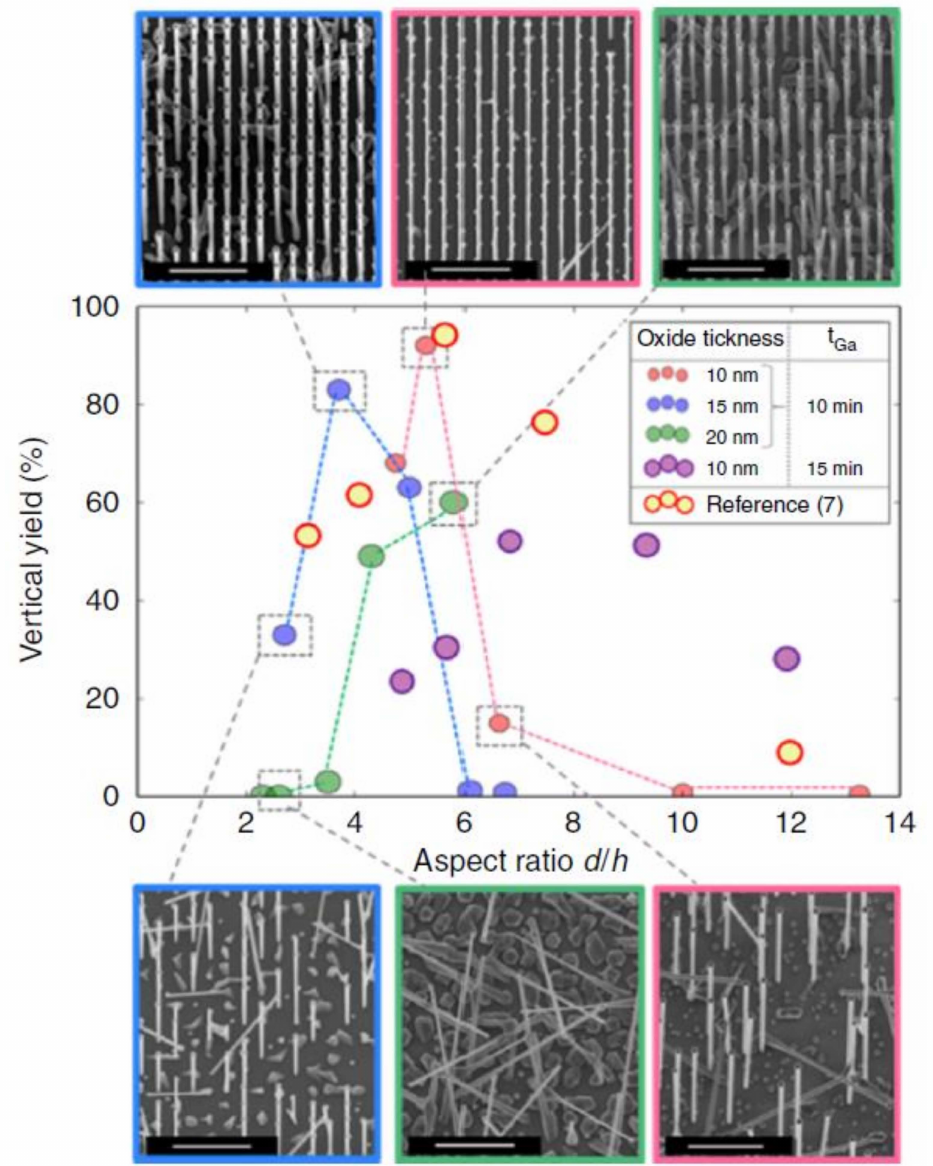
Figure 9. Results of an optimization study of the yield of vertical GaAs nanowires, grown by a self-catalyst method on silicon substrate by the hole aspect ratio in the SiO 2 mask template used to assist the growth. Different values of the aspect ratio d/h were obtained using three different oxide thicknesses h of 10, 15, and 20 nm (corresponding to the red, blue, and green data points, respectively), and different diameters d. All samples were grown under the same growth conditions. The central graph shows the dependence of the vertical yield for the nanowire arrays as a function of the hole aspect ratio, while the inserts show 20 ◦ titled SEM micrographs of the samples with the best (upper part images) and worst (lower part images) yields. The maximum yields were obtained for the aspect ratios between 4 and 6 for all three oxide thicknesses used. Outside this range, the yield is compromised by the presence of parasitic growth. The central graph reports also the results of Ref. [104], following the same trend and represented by the yellow points (Reprinted with permission of Ref.